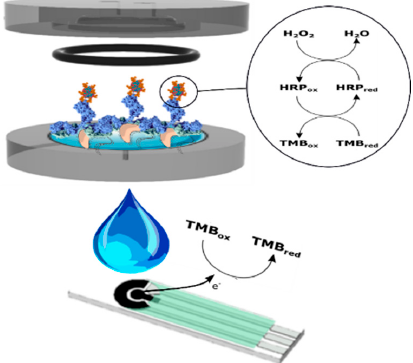
Figure 1. General scheme. The membrane retains the Legionella cells for the subsequent immunoassay and the chronoamperometric transduction of the signal. and the chronoamperometric transduction of the